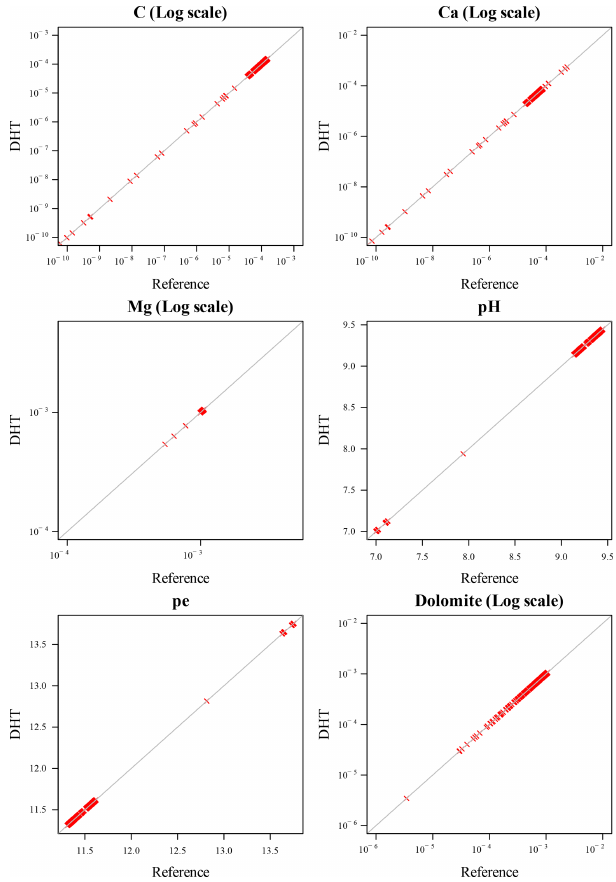
Figure 10. Logarithmic variables, 5_5 digits: scatterplot of DHT and reference variables after 300 iterations. With only five digits for the logarithmic variables, the DHT simulations maintain excel- lent accuracy also for small variables values, as opposed to the case displayed in Fig. 9.